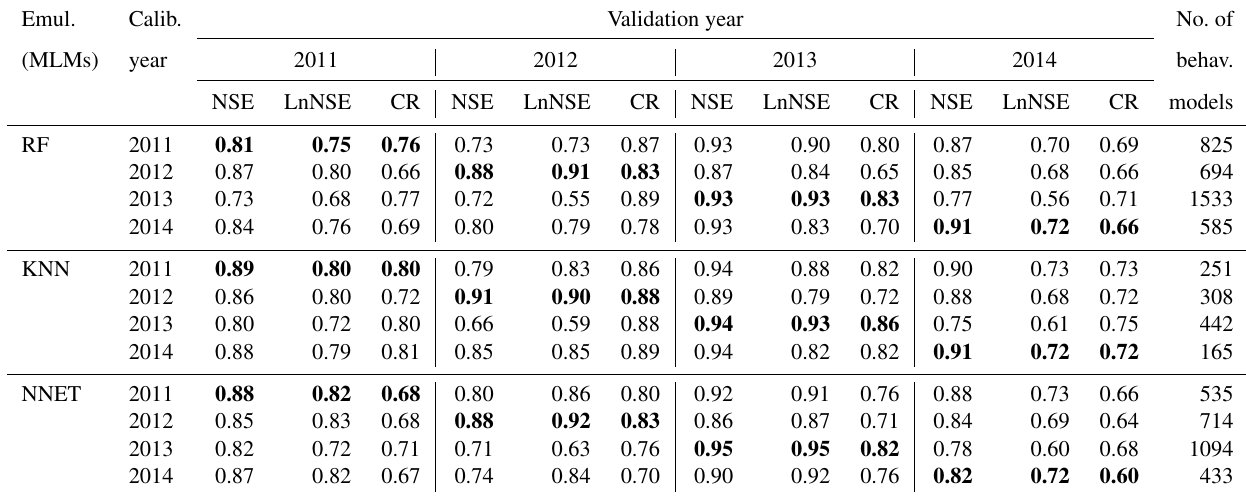
Table 4. Cross-validation of the streamflow predictions of models identified using the coupled ML emulators and MC simulation. The efficiency metrics for the calibration period are shown in bold font. Emul.